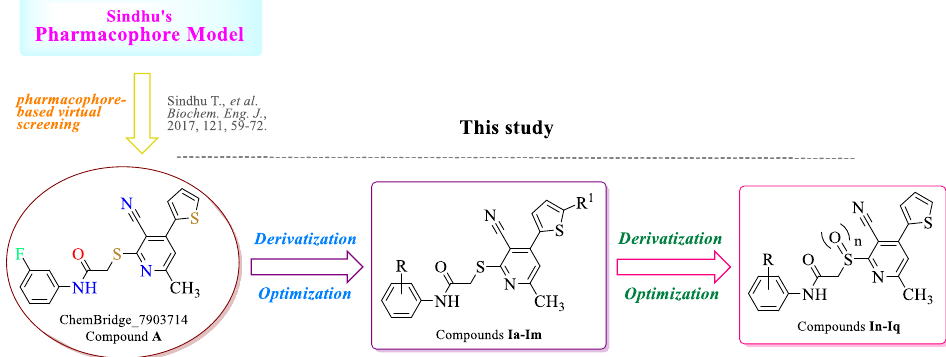
Figure 2. The design of the target compounds.